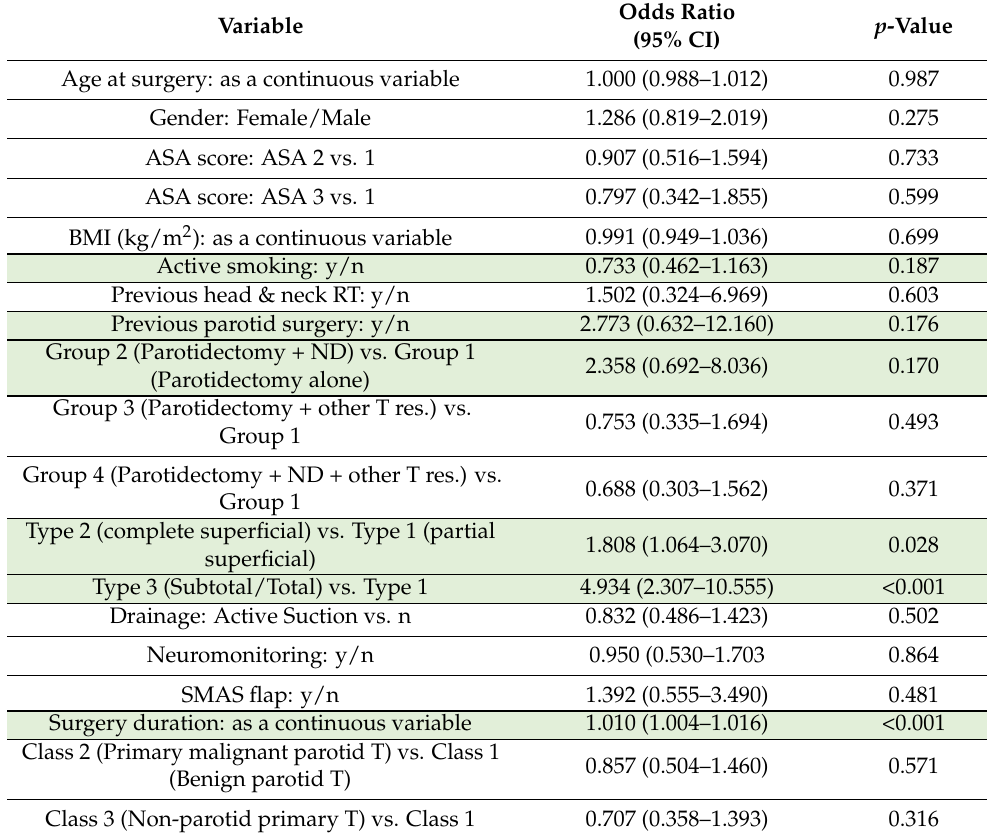
Table 5. Univariate logistic regression with selected variables for local complications (surgical procedures: n = 436). Variables with a p -value < 0.2 selected for multivariate logistic analysis are in colored lines. Abbreviations: y: yes, n: no, ASA: American Society of Anesthesiologists, BMI: Body Mass Index, RT: radiotherapy, T: tumor, res.: resection, ND: neck dissection, SMAS: